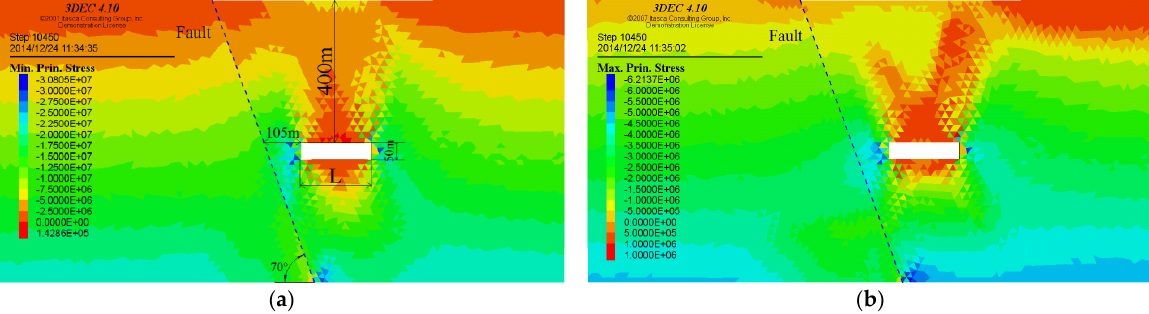
Figure 19. The stress field distribution in the surrounding rock at the excavation size of 200 m × 50 m, they should be listed as: ( a ) Maximum principal stress distribution; ( b ) Minimum principal stress distribution.